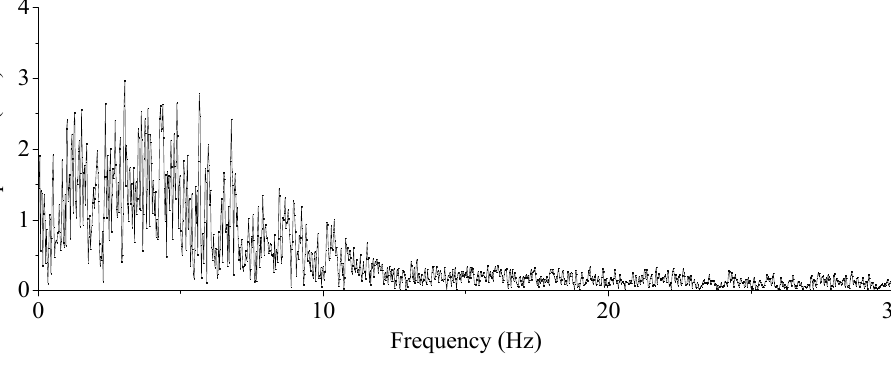
Figure 10. Fourier spectrum of El Centro wave.